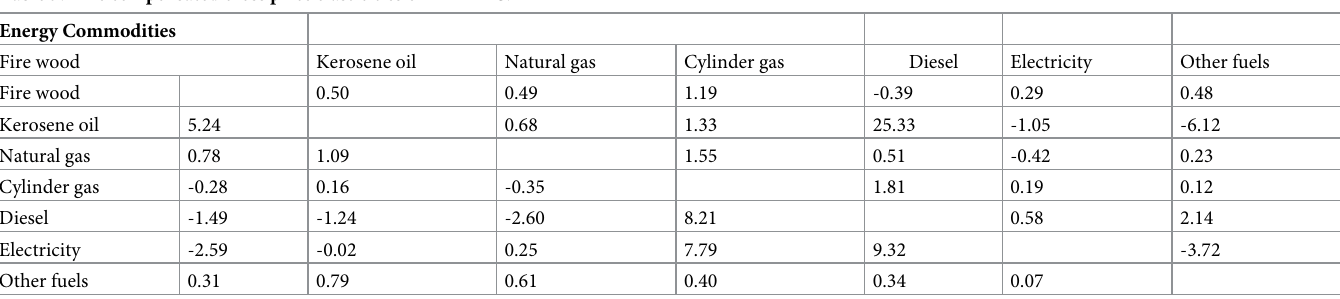
Table 7. The compensated cross price elasticities of LA-AIDS.